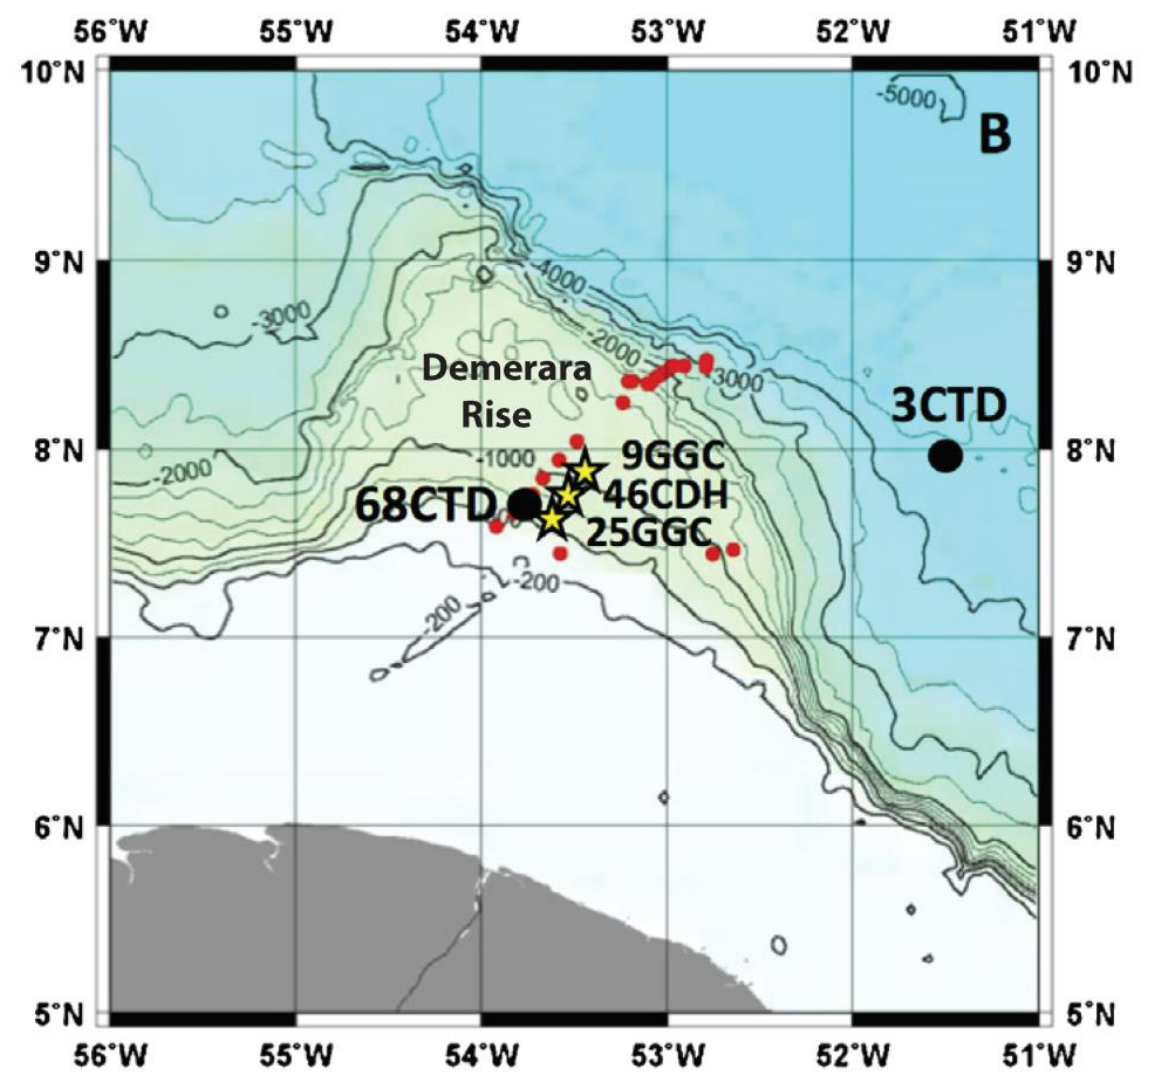
Figure 1. ( A ) Map of the northeastern continental margin of South America showing the Demerara Rise and general flow of the surface North Brazil Current. ( B ) Demerara Rise bathymetry and locations of our studied cores (stars).